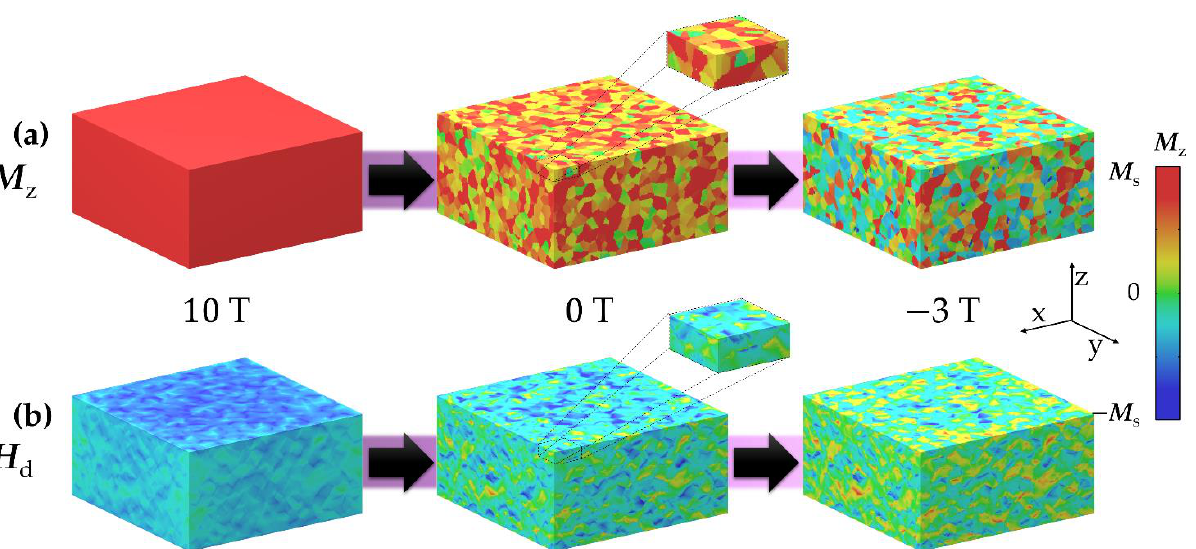
Figure 5. Distribution of the demagnetization factors ( – H d / M z ) of each element at saturation (red) and in the remanent state (blue). The black dashed lines indicate the 10% truncated means.